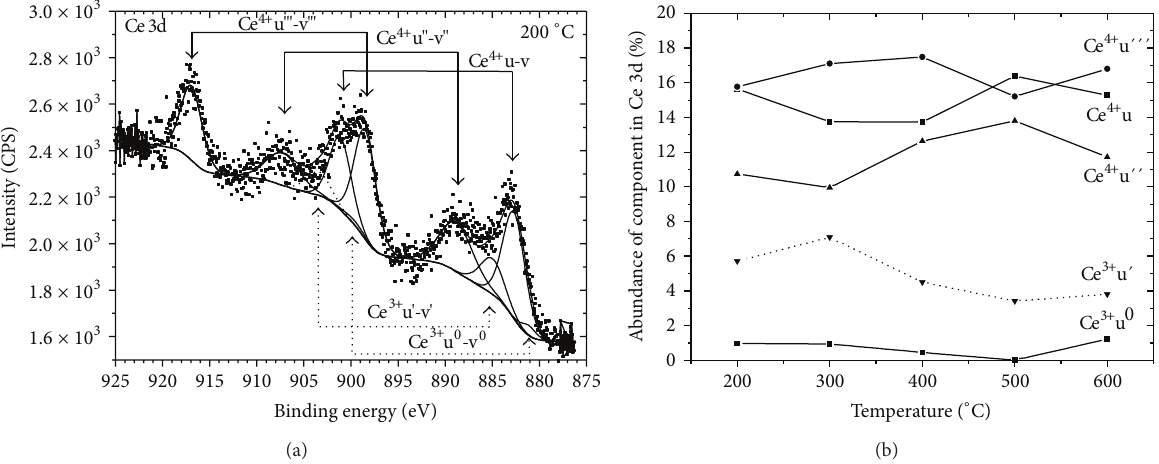
Figure4:(a)TheCe3dpeakwithdeconvolutedcomponentsforthesamplepreparedatthecalcinationtemperatureof200 ∘ C.(b)Dependence of the abundances of the Ce 3d components on the calcination